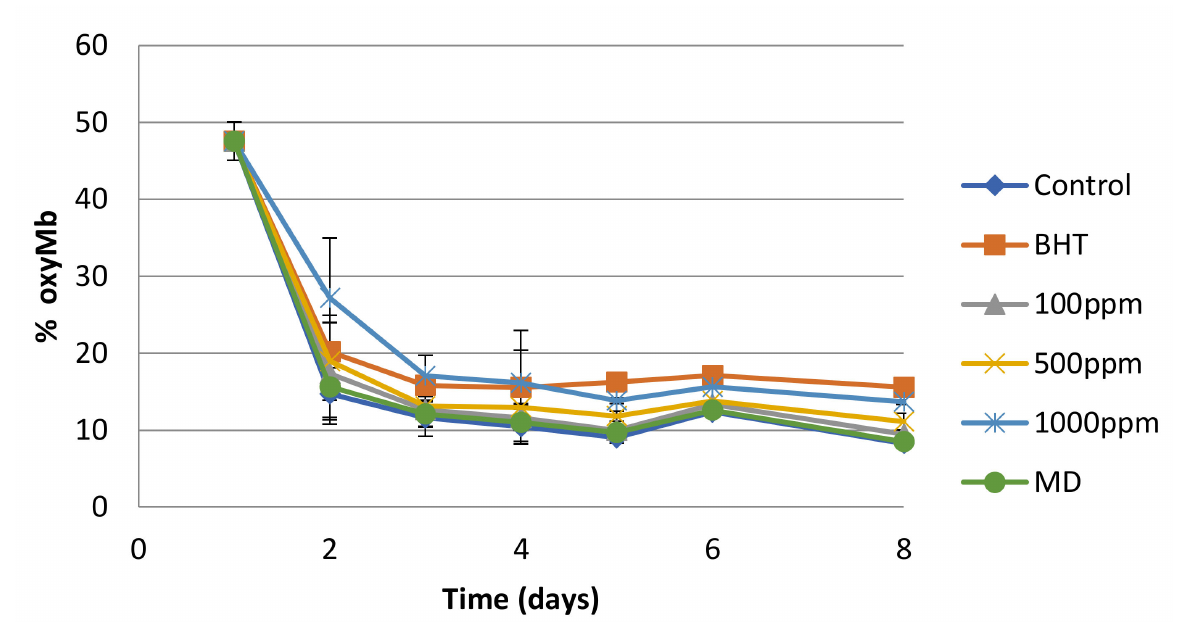
Figure 3. %oxyMyoglobin during refrigerated storage of minced bovine